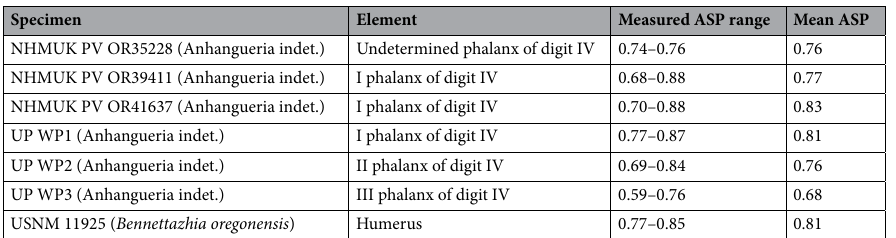
Table 3. Mean ASP of the appendicular skeleton of eight pterodactyloid specimens (from Martin & Palmer23).